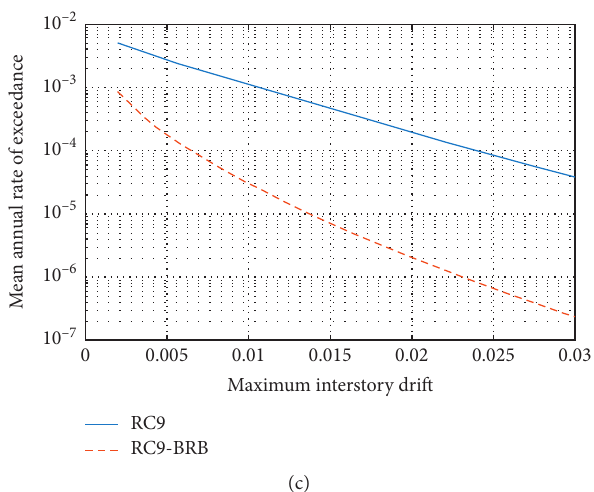
Figure 8: Comparison of the MID hazard c urves for the RC and the RC-BRB buildings with (a) 3 stories, (b) 6 stories, and (c) 9